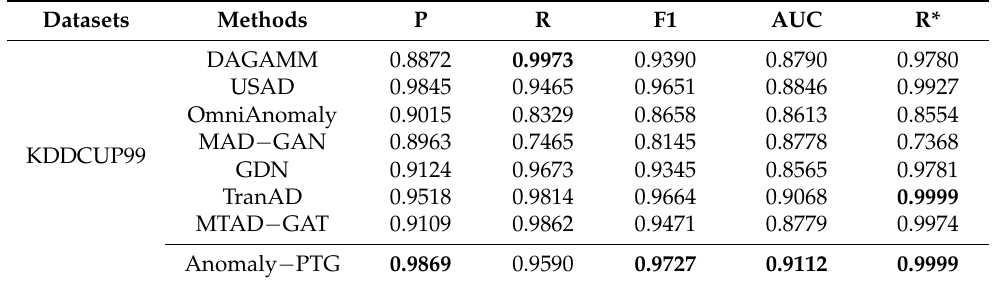
Table 4. The anomaly-PTG model was compared with baseline method on the KDDCUP99